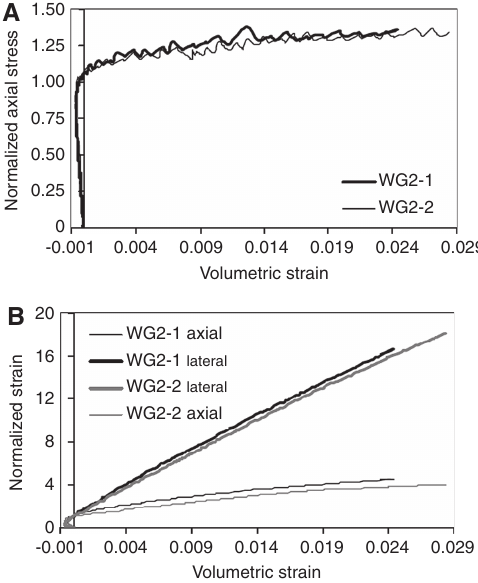
Figure 8 WG2 specimens: (A) normalized axial stress versus volumetric strain, (B) normalized strain versus volumetric